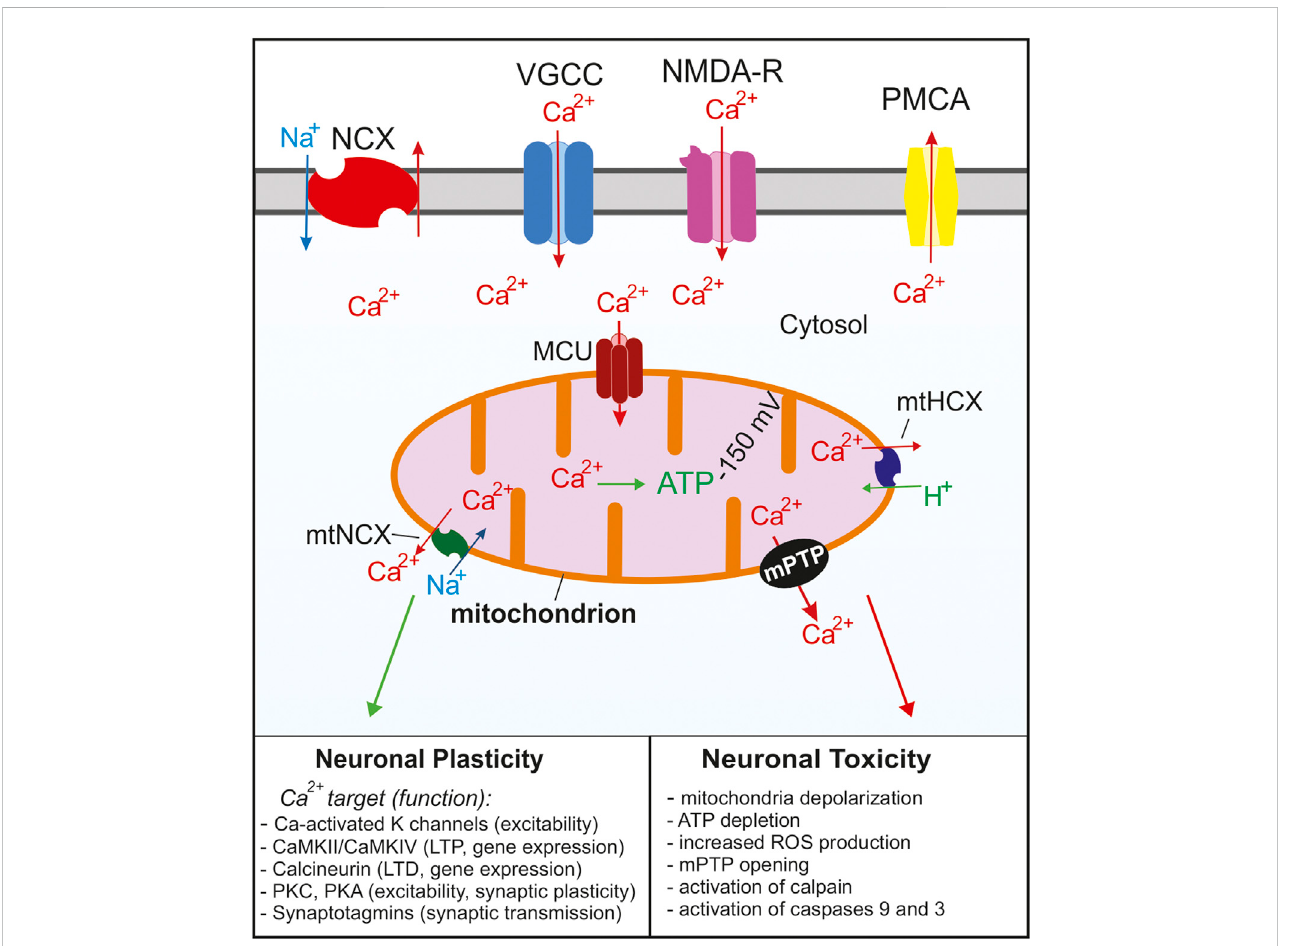
FIGURE 1 SummaryoftheCa 2+ signalingmechanismsinneuronsthatregulatecytosolicandmitochondrialCa 2+ concentrations.Ca 2+ entersthecellthroughvoltagegated Ca 2+ channels (VGCC) following depolarization or through glutamate NMDA receptors. As the cytosolic Ca 2+ concentration increases, the MCU complex opens and Ca 2+ entersthemitochondria.Ca 2+ israpidlyremovedfromthecytosol via Na + /Ca 2+ exchangers(NCX)andplasmamembraneCa 2+ ATPases(PMCA).Asthecytosolic Ca 2+ concentration decreases Ca 2+ isslowly released from the mitochondria through Na + /Ca 2+ (mtNCX)exchangers and H + /Ca 2+ exchangers (mtHCX). Proper Ca 2+ bufferingiscriticalfornormalneuronalfunctionsandneuronalplasticity.ImpairedbufferingandCa 2+ overloadleadstotheopeningofthemPTPandactivationof apoptotic pathways and is implicated in many neurological diseases. For simplicity, the ER and other Ca 2+ organelles are omitted from the